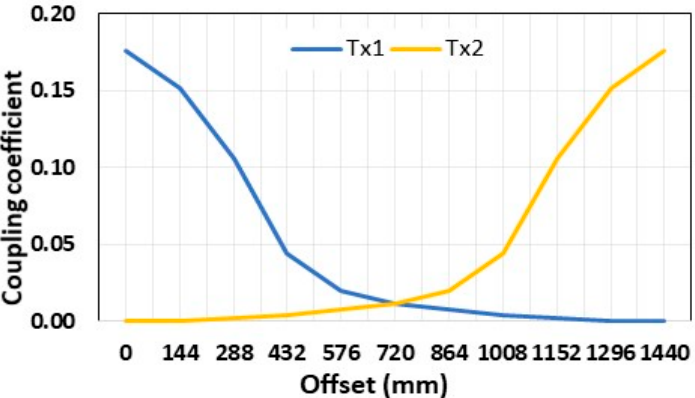
Figure 13. Variation of the coupling coefficient for every step of the Offset in the DD–DD configuration.